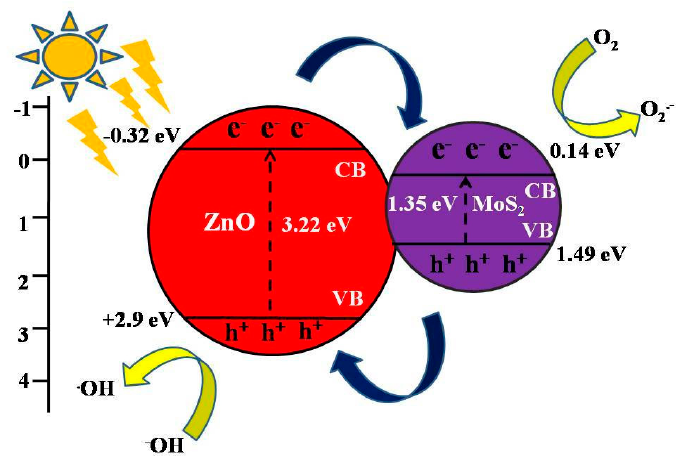
Figure 13. Pictorial representation of the mechanism for MB degradation using MoS 2 /ZnO heterostructure in the presence of natural solar light.